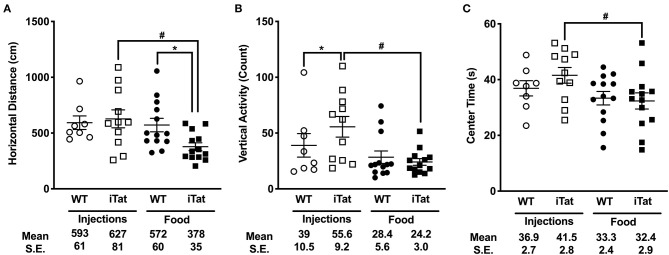
Prolonged HIV-1 Tat expression led to slower ambulation, reduced vertical activity, and reduced center time compared to acute Tat expression in iTat mice. (A) Horizontal Distance, (B) Vertical Activity, and (C) Center Time in iTat and WT mice were measured. Average per minute values for each parameter were plotted. The WT mice (n = 7–8, open circles) and the iTat mice (n = 10–11, open squares) received acute induction by DOX i.p. injections, while the WT mice (n = 13, solid circles) and the iTat mice (n = 13, solid squares) received prolonged induction via DOX food. Each bar represents the mean ± SEM. *p < 0.050 for same Treatment Time comparisons between Strains, #p < 0.050 for same Strain comparisons across Treatment Time by two-way ANOVA using Treatment Time and Strain as variables.